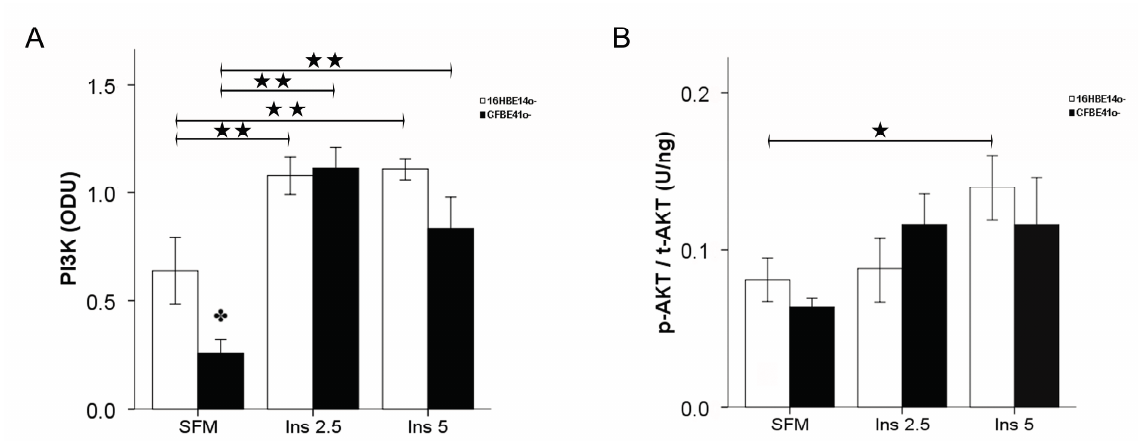
p85 PI3K content in both cell lines; ( B ) p-AKT/t-AKT ratio expressed in U/ng, was